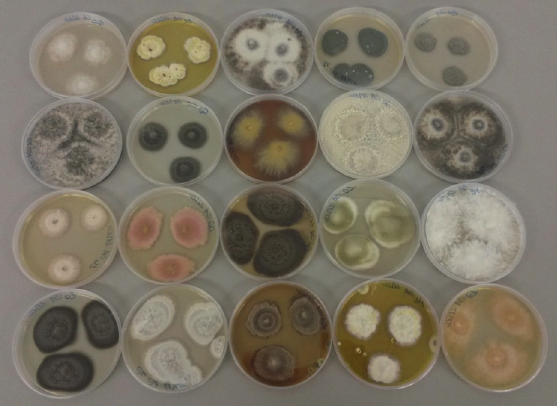
Figure 2 - Diversity of colonies after purification of fungi isolates from different environments of the Vitória Academic Center -